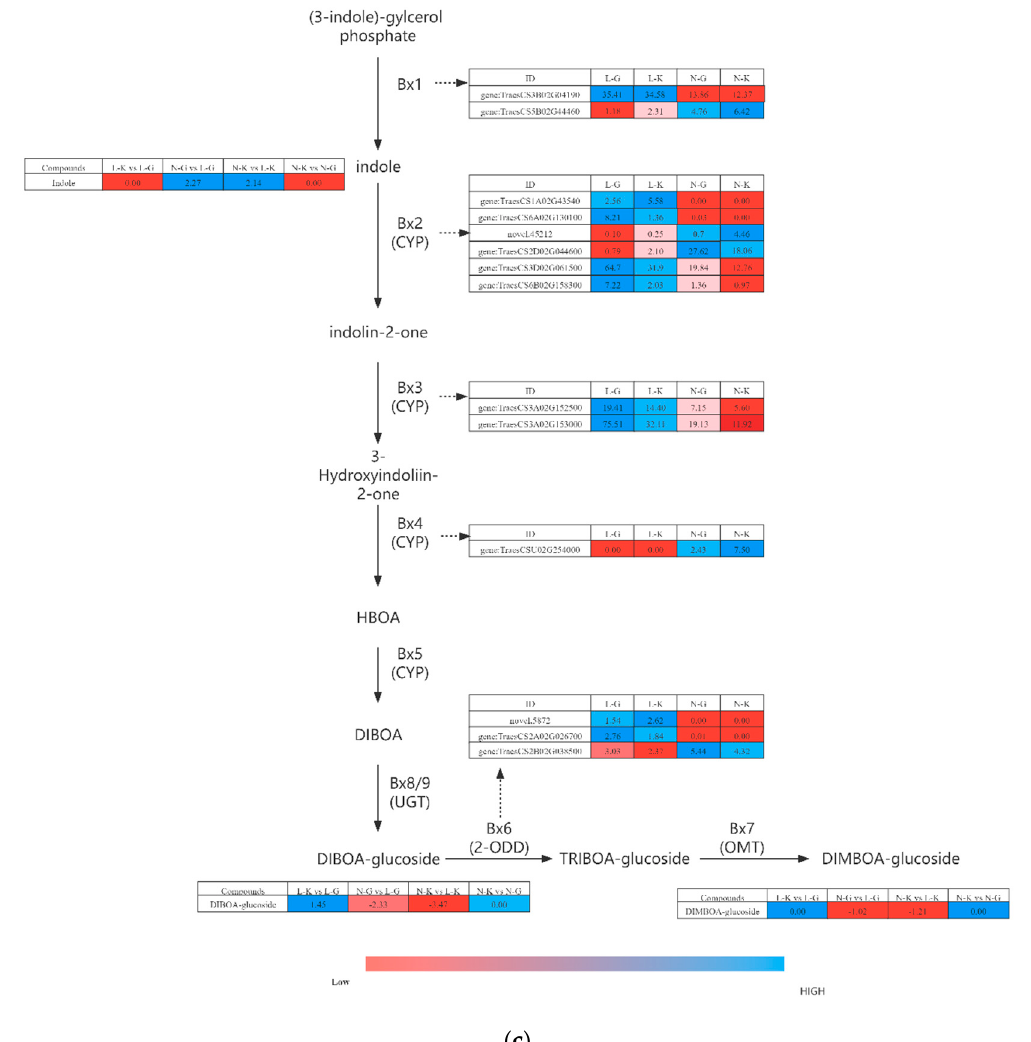
Figure 7. ( a ) Network diagram of differential genes and metabolites in Benzoxazinoid biosynthesis; ( b ) network diagram of differential genes and metabolites in arginine and proline metabolism; ( c ) biosynthesis mechanism of Benzoxazinoid in different combinations, blue and red colors represent the up-regulation and down-regulation of gene expression and metabolites,